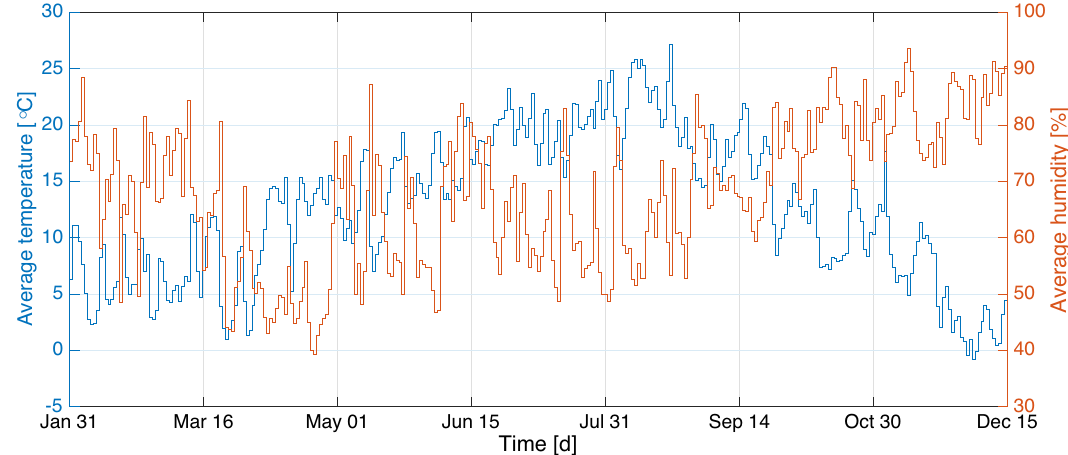
Figure 2. Average from the daily average temperature and relative humidity from the three weather stations in Germany: Berlin-Marzahn (Berlin), München-Stadt (Bavaria), Stuttgart-Schnarrenberg (Baden-Württemberg). Time window spans from January 31 until December 15, 2020. The tuples (Min, Max, StDev) are given by (− 0.766 ◦ C, 27.13 ◦ C, 6.45 ◦ C) for the temperature and (39.38%, 93.53%, 12.71%) for the relative humidity, respectively.